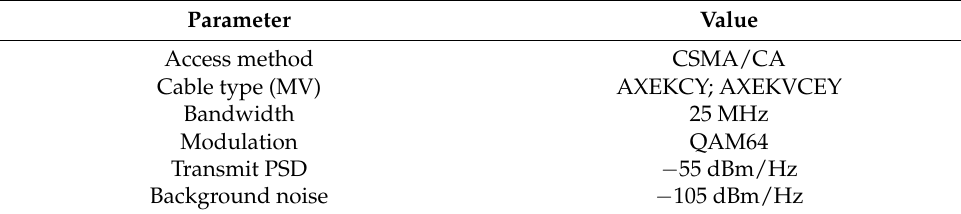
Table 11. Input channel parameters of the experimental simulation of the real BPL topology.